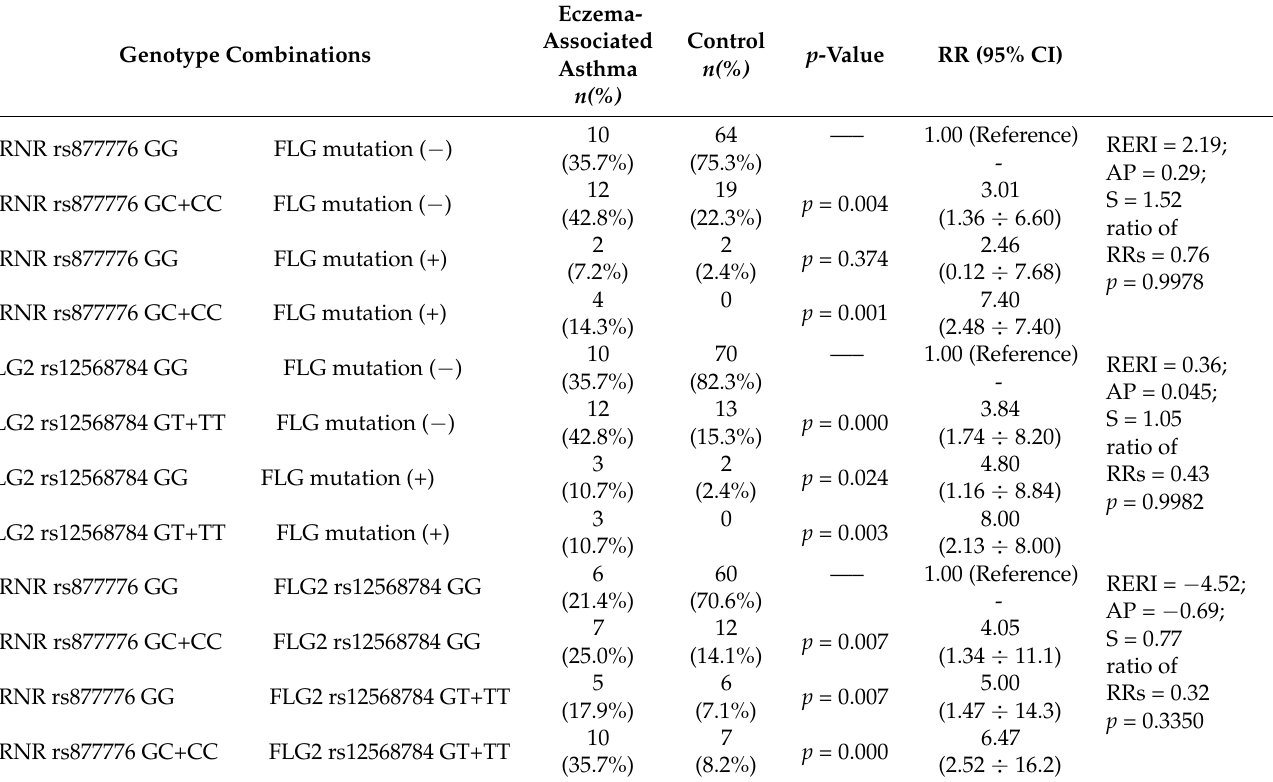
Table 6. Interaction between HRNR rs877776 and FLG2 rs12568784 and the FLG mutations in eczema-associated